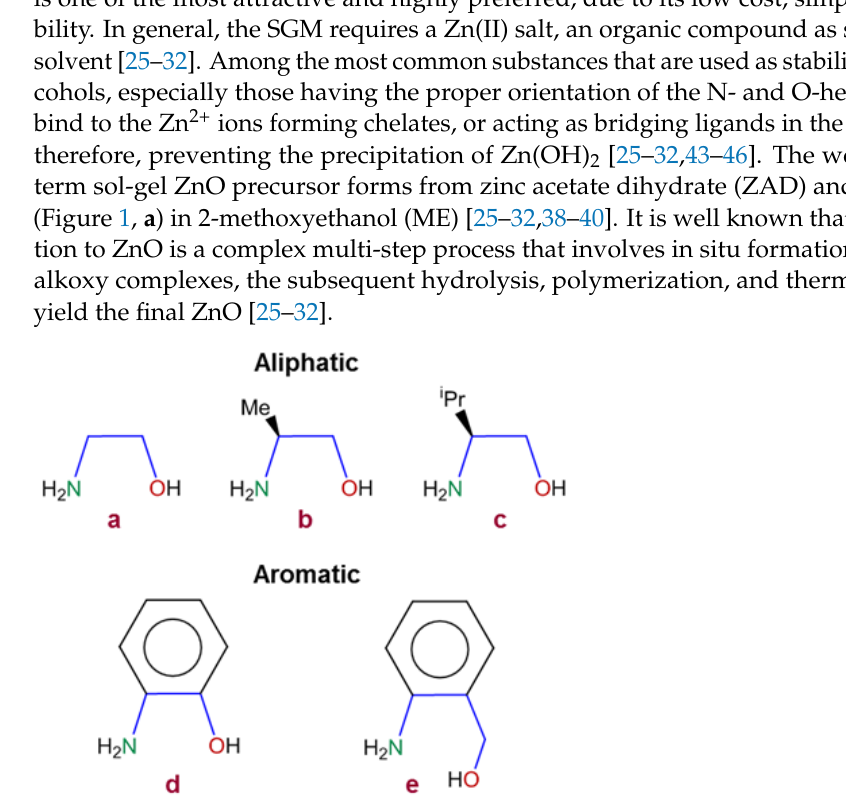
Figure 1. Molecular structure of the AAs a – e used as precursors to generate the ZnO thin films 1a – 1e .